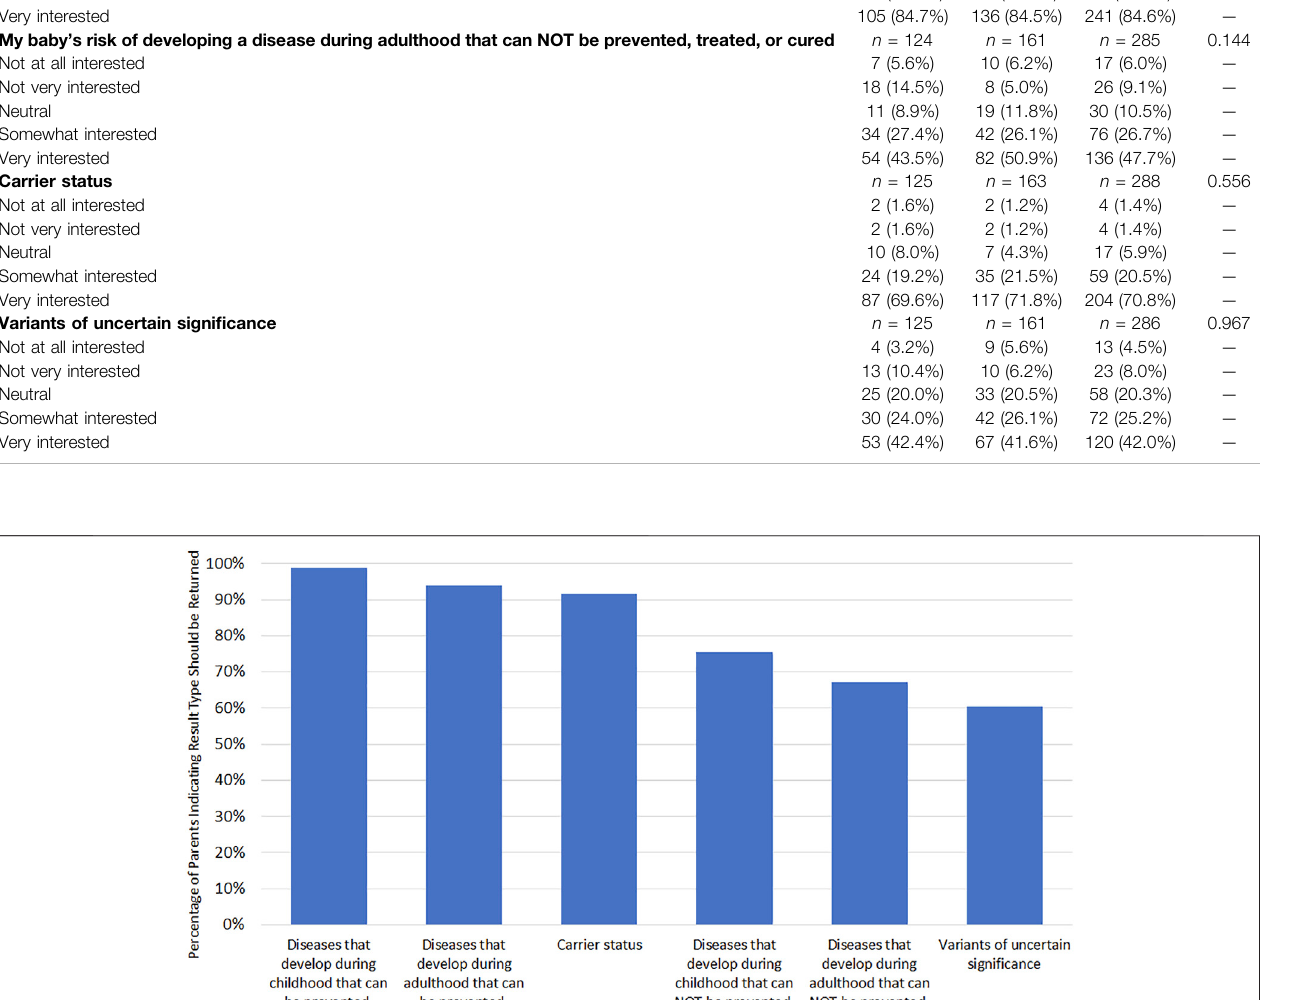
Frontiers in Genetics |